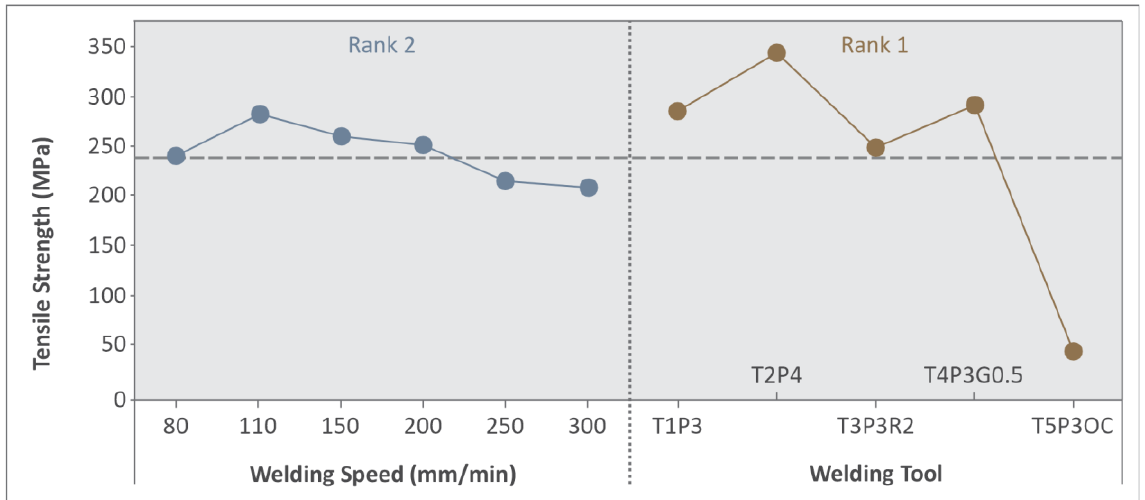
Figure 7. Main effect plots for the two FSW parameters studied, i.e., welding speed and welding tool.